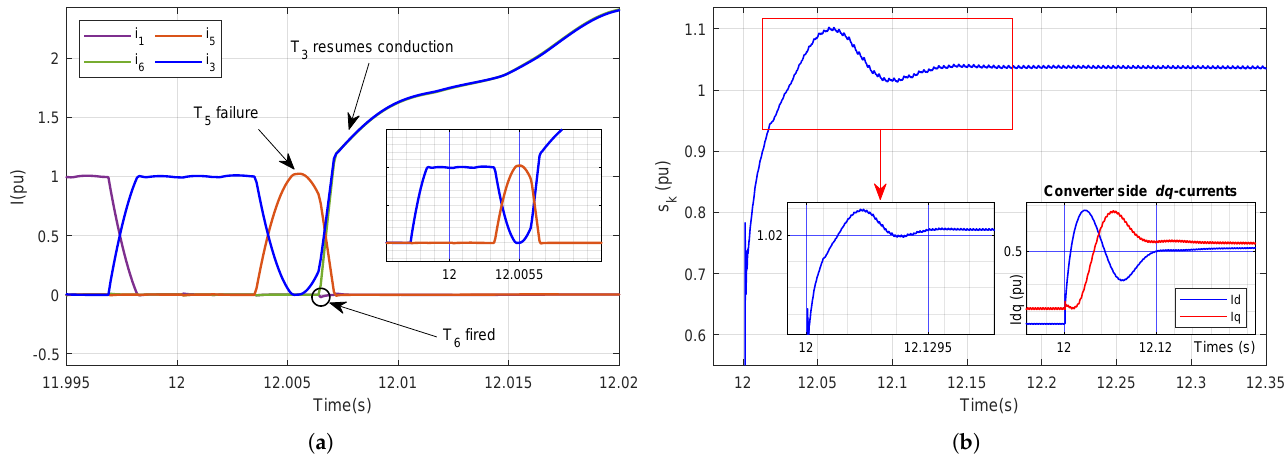
Figure 3. Inverter commutation failure simulation. Dynamic detail: ( a ) valve currents under commu- tation failure. ( b ) VSC Complex power— (cid:126) S k .